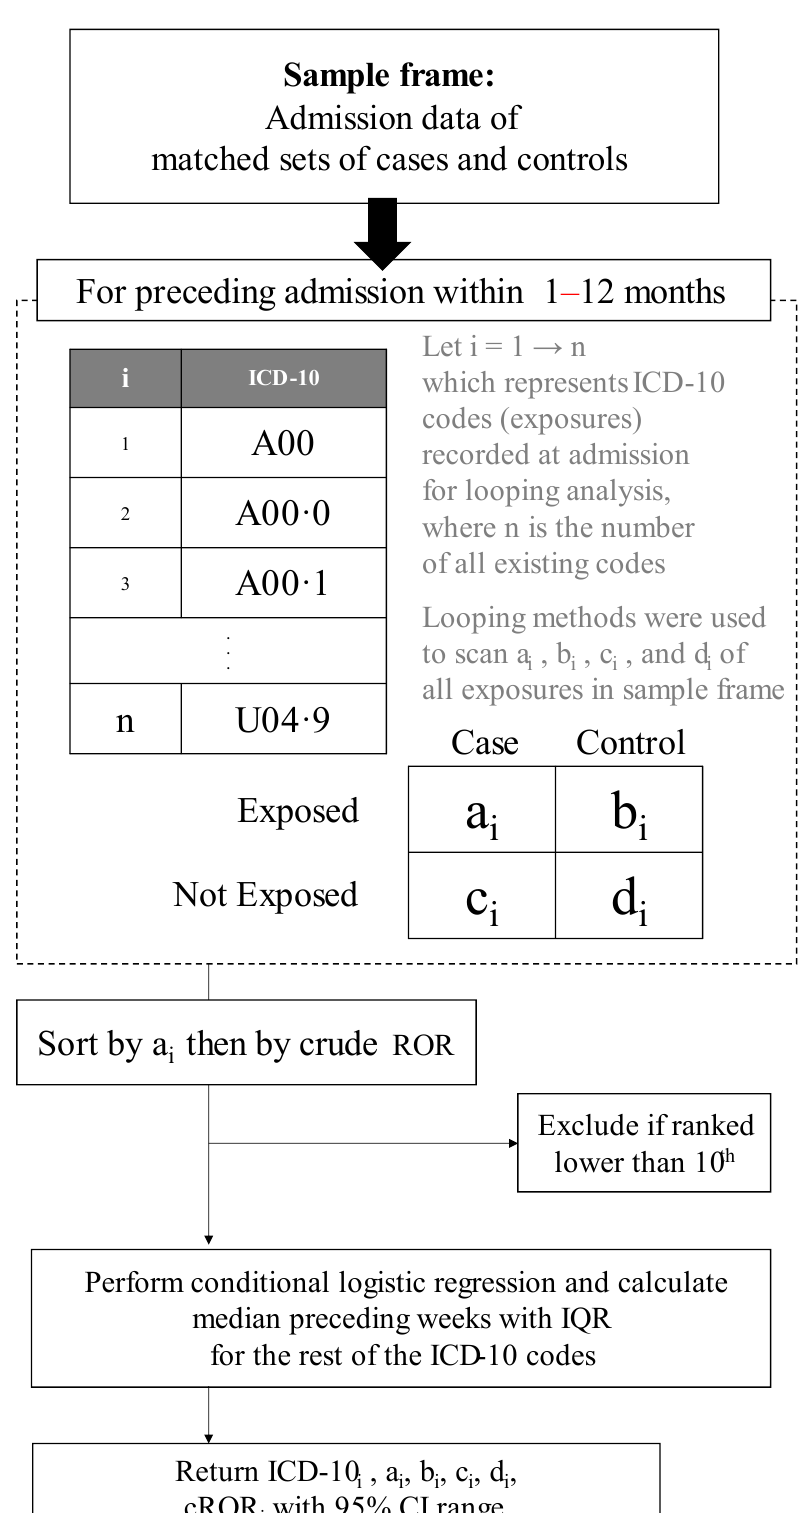
Figure 1. Algorithm to rank the 10 commonly hospitalized comorbidities preceding tuberculosis. CI, confidence interval; cROR, conditional relative odds ratio; IQR, interquartile range; ROR, relative odds ratio; TB, tuberculosis.